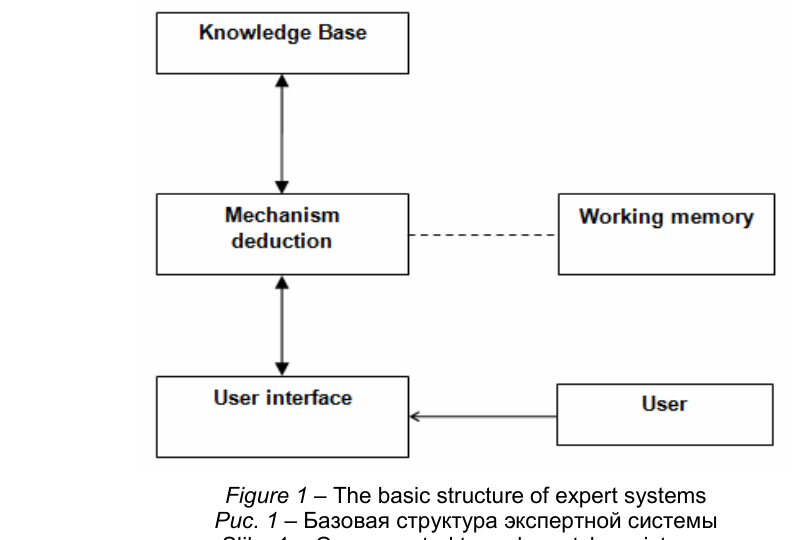
Figure 1 – The basic structure of expert systems Рис . 1 – Базовая структура экспертной системы Slika 1 – Osnovna struktura ekspertskog